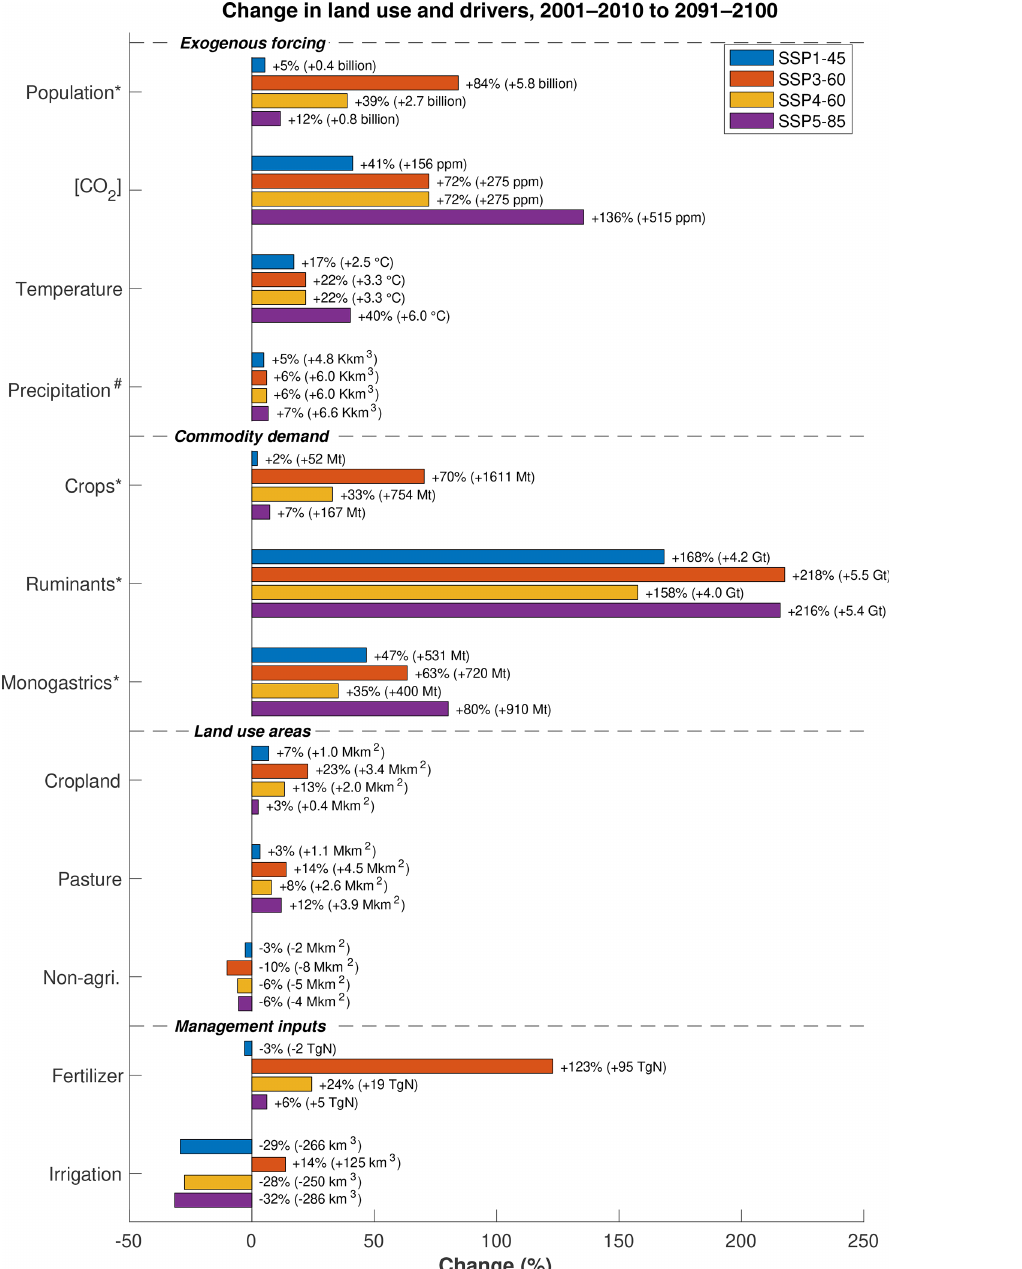
Figure 2. Percent change in global socioeconomic, land management, and atmospheric variables between 2001–2010 and 2091–2100. Ruminant demand given in units of feed-equivalent weight. ∗ The variables whose baseline is 2010 instead of the average over 2001–2010. # The time periods compared for precipitation were 1971–2000 and 2071–2100 due to high temporal